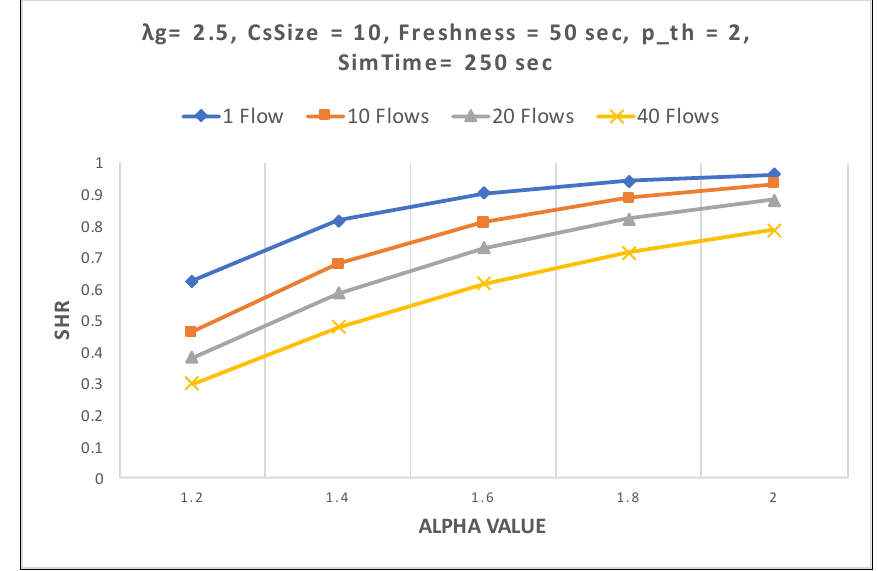
Figure 6. SHR as a function of the Zipf popularity